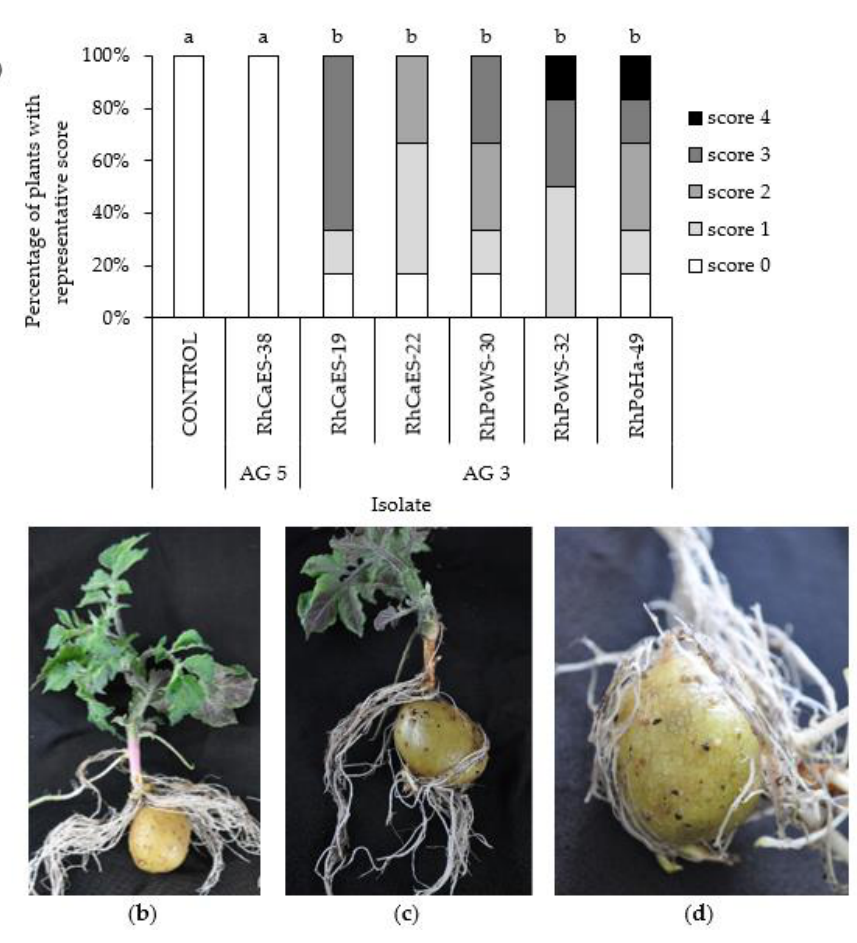
Figure 8. Pathogenicity towards potato (cv. Bintje) of six R. solani isolates belonging to AG 3 and AG 5, isolated from carrot and potato. ( a ) Percentage of plants with Rhizoctonia symptoms, 33 dpi ( n = 6). Plants were scored using a scale ranging from 0 (no damage) to 4 (all sprouts dead). Data were statistically analyzed using Mann–Whitney tests. The different letters above the bars indicate significant differences in pathogenicity between isolates ( p = 0.05); ( b ) a healthy plant: no symptoms induced by isolate RhCaES-38 (AG 5); ( c ) black scurf symptoms on potato tubers and girdling of the stem base induced by isolate RhPoWS-32; ( d ) formation of black scurf on potato tubers by isolate RhCaES-19 (AG 3).